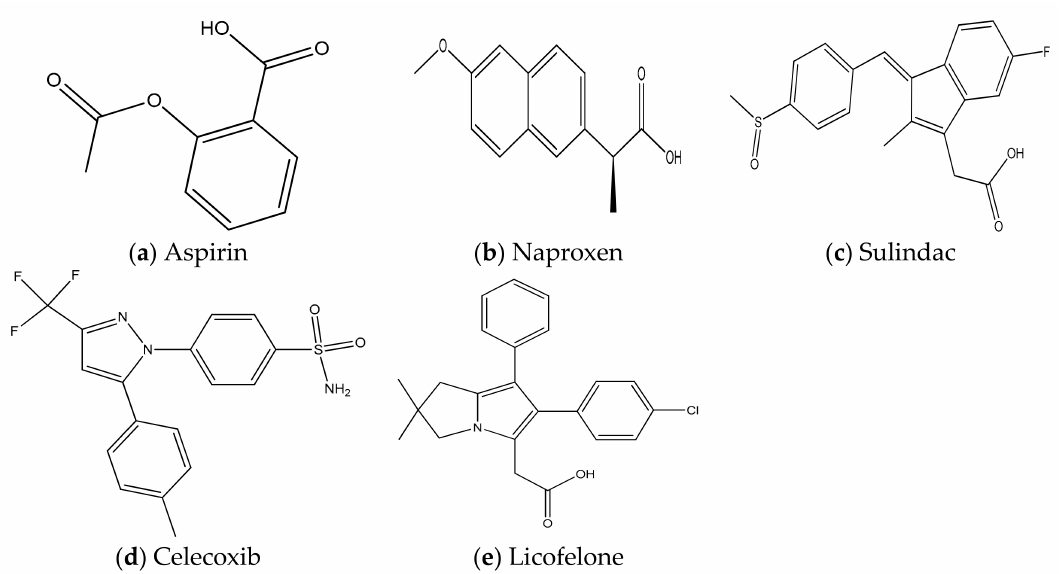
Figure 1. Chemical structures of some of the anti-inflammatory agents with chemopreventive potentials against colorectal cancers. Chemical structures of aspirin ( a ), naproxen ( b ), sulindac ( c ), celecoxib ( d ) and licofelone ( e ).